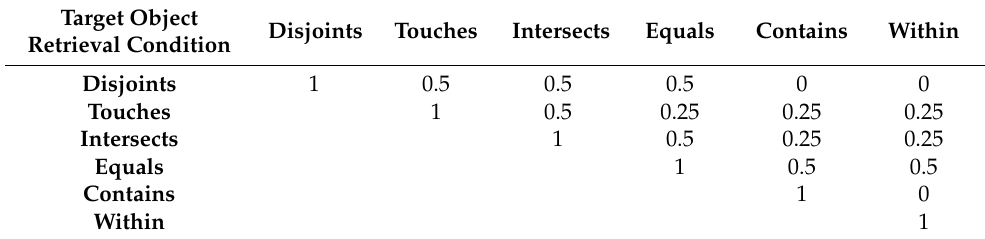
Table 2. Conceptual similar matrix of topological